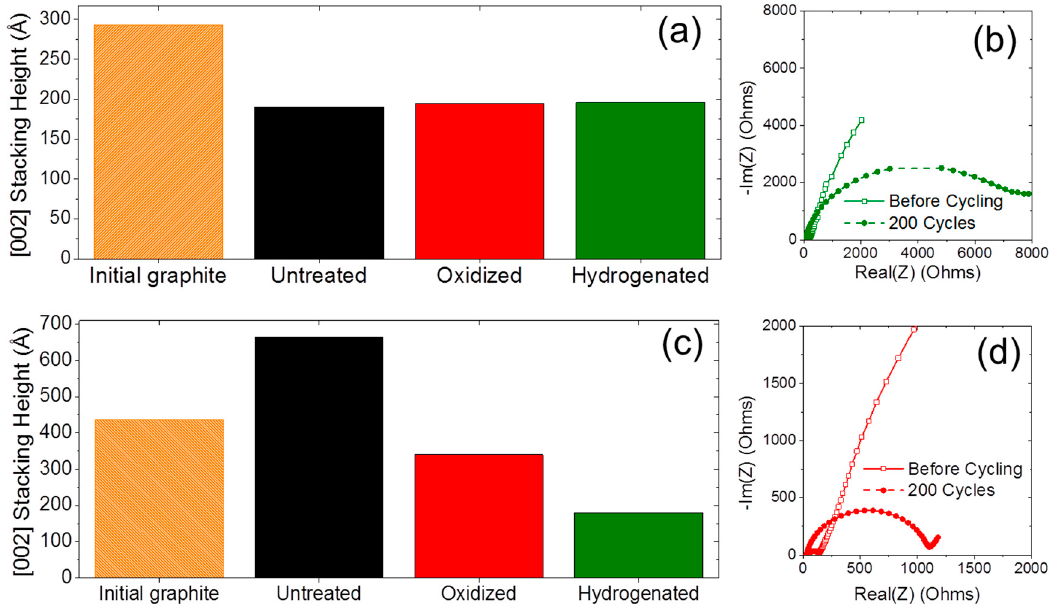
Figure 3. ( a ) X-Ray Diffraction (XRD) analysis of long-range graphitic ordering in the [002] direction of the initial MCMB cathode and different surface treated materials after C/2 cycling; ( b ) Nyquist impedance plot that compares the charge transfer resistance between the hydrogenated MCMB cathode and the current collector before and after cycling; ( c ) XRD analysis of the SFG cathode before and after cycling. Note that the cycled untreated material retained partial charge (i.e., ions intercalated into its structure), which likely contributed to higher [002] long-range ordering; ( d ) Nyquist impedance plot that compared the charge transfer resistance of the oxidized SFG cathode before and after